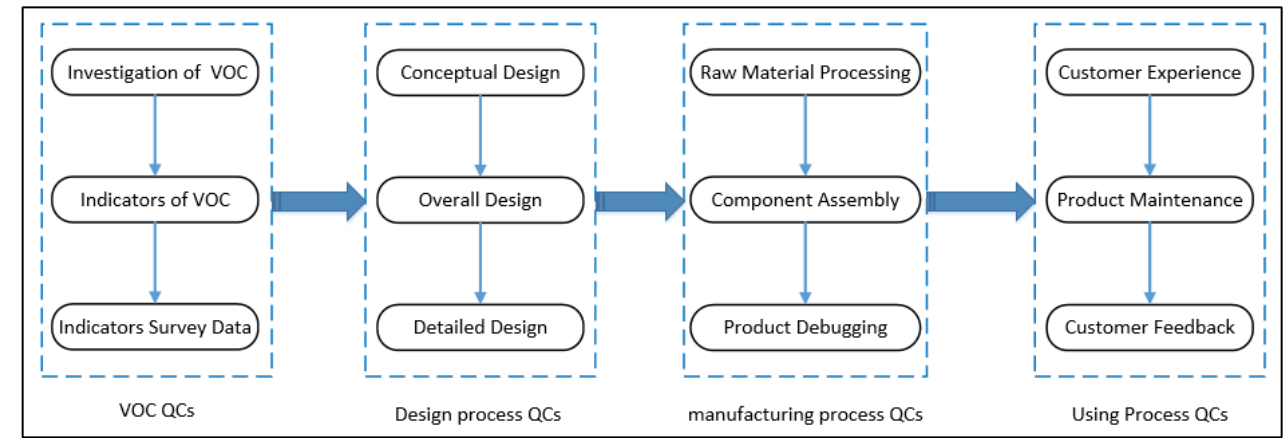
Figure 2. Flow chart of the mapping law of quality characteristics.